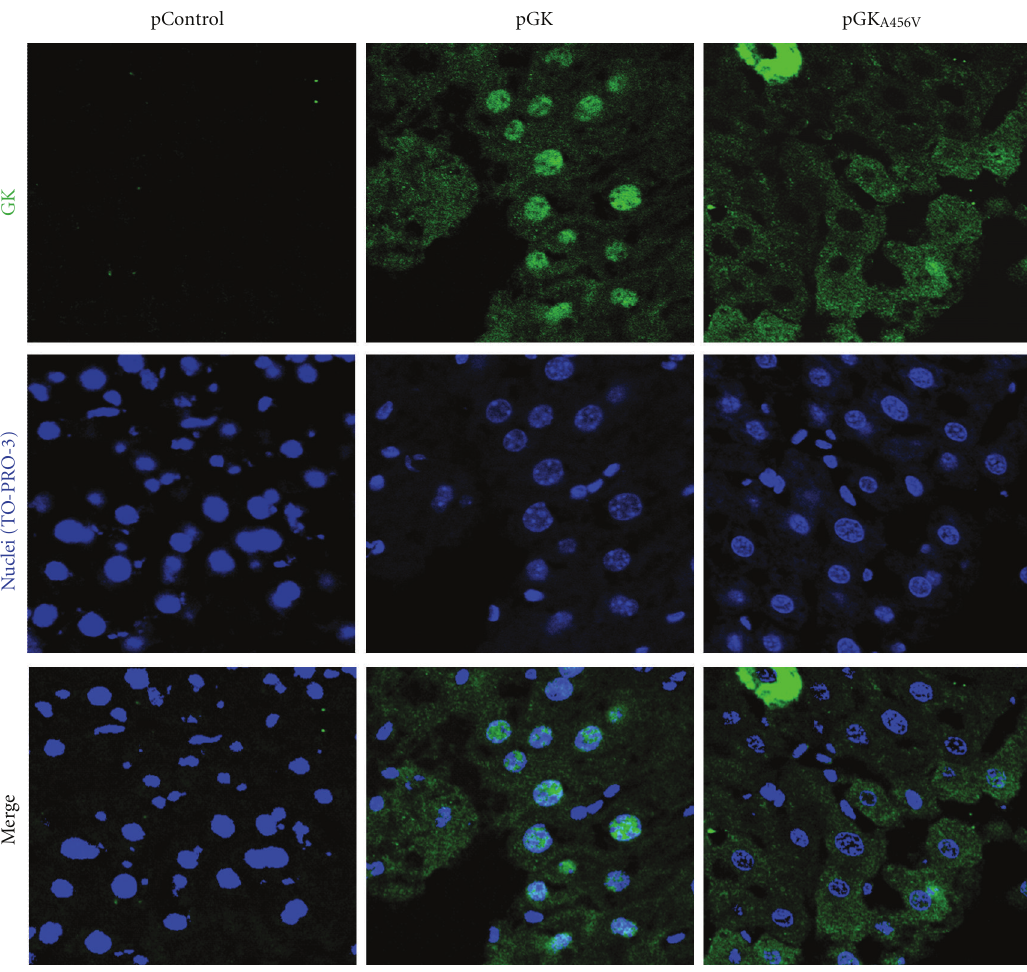
Figure 2: GK and GK A456V localization inside hepatocytes. Liver sections of 5-hour fasted mice injected with pControl, pGK, or pGK A456V were immunostained with GK antibody. TO-PRO-3 was used to visualize